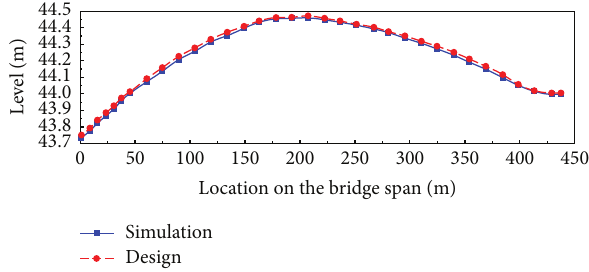
Figure 9: Comparison between design and simulated initial space location of bridge.